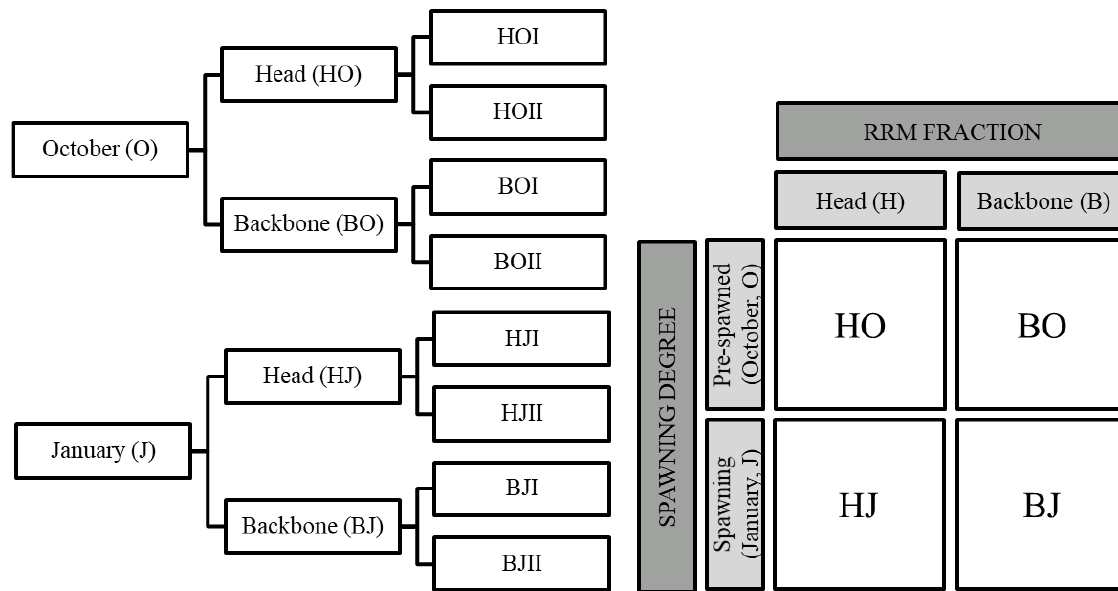
Figure 7. Schematic overview of the samples generated from ( left ), and the factorial design used for ( right ) enzymatic hydrolysis of saithe head and backbones from October 2019 (pre-spawned) and January 2020 (spawning) [3] .